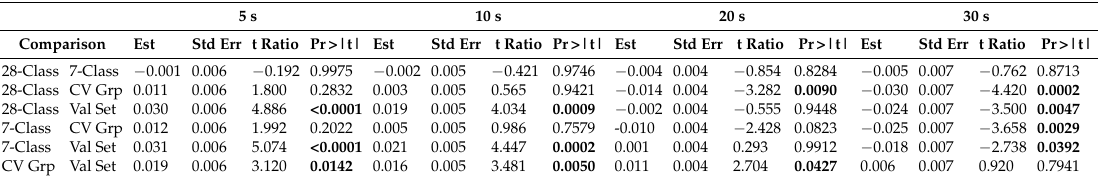
Table 4. Tukey HSD pairwise comparisons for the interaction of training method and sequence length at specified sequence lengths. Significant results are shown in bold